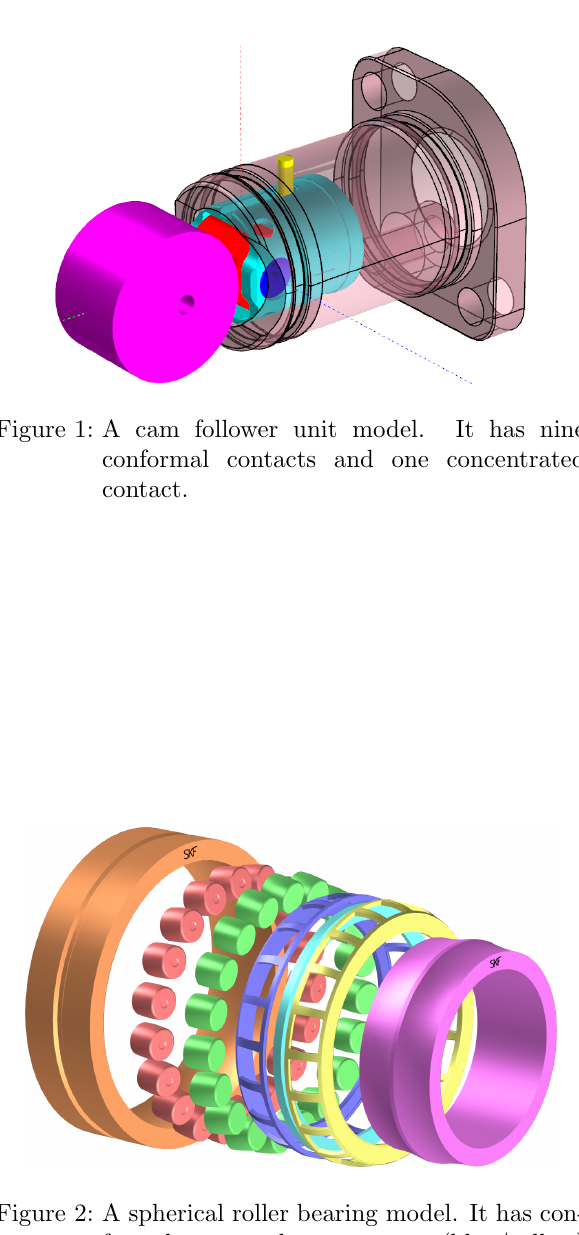
Figure 2: A spherical roller bearing model. It has con- formal contacts between cages (blue/yellow) and inner/outer ring, guide ring (cyan) with inner/outer ring or cages. Typical concen- trated contacts are rollers with inner/outer